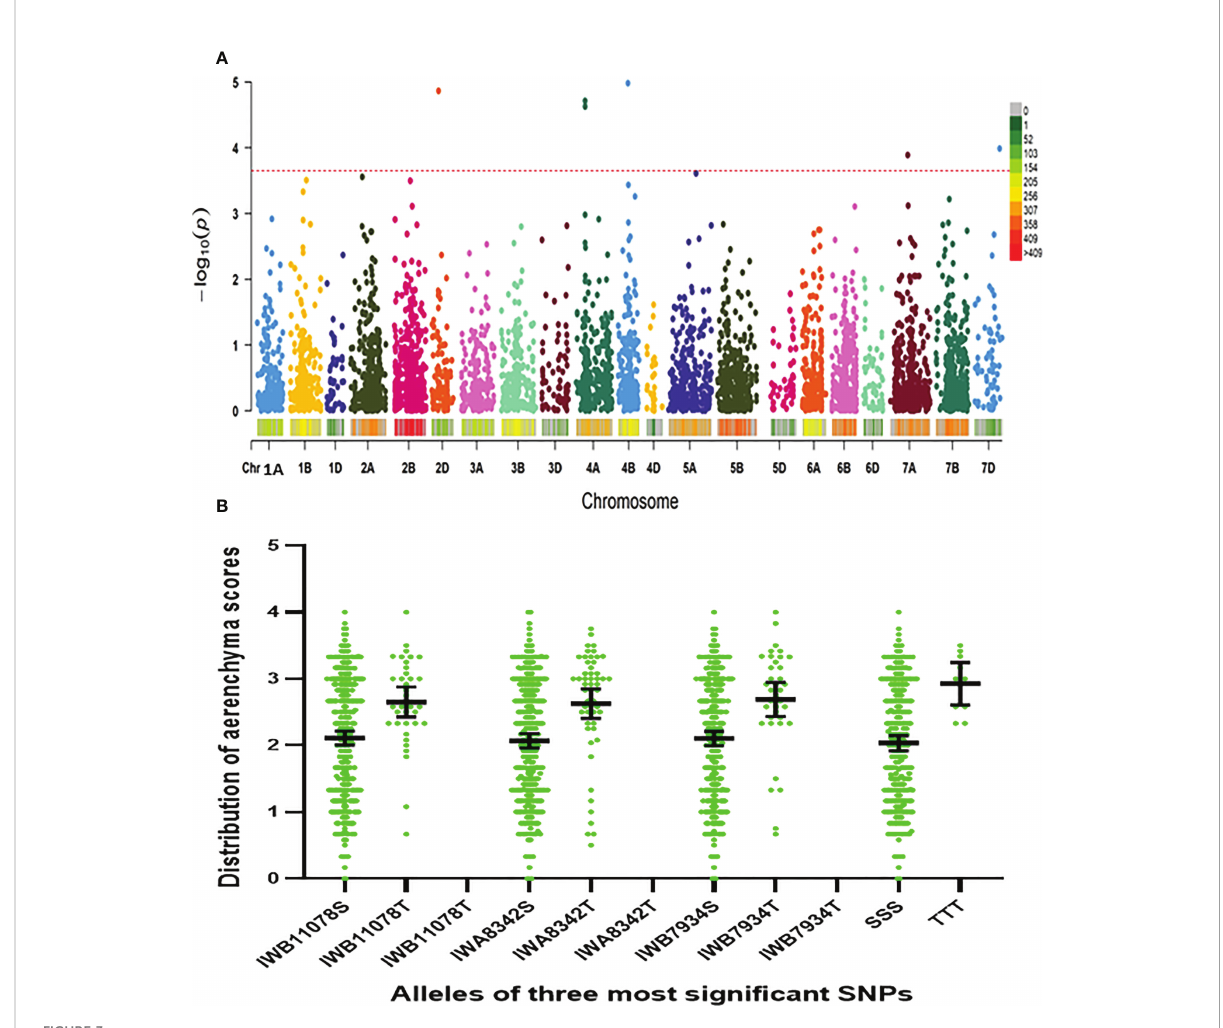
FIGURE 3 Marker-trait (aerenchyma formation) associations. (A) : GWAS aerenchyma formation using FarmCPU: Lod values of all the markers; (B) : distribution of aerenchyma formation of genotypes with three markers signi fi cantly correlated with aerenchyma formation and the combination of all three markers. T, tolerance allele; S, sensitive allele; TTT, tolerance alleles of all three markers; SSS, sensitive alleles of all three